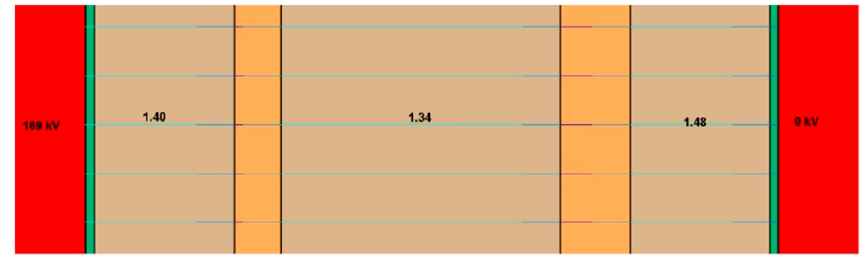
Figure 12. Safety factors for HV to regulation.